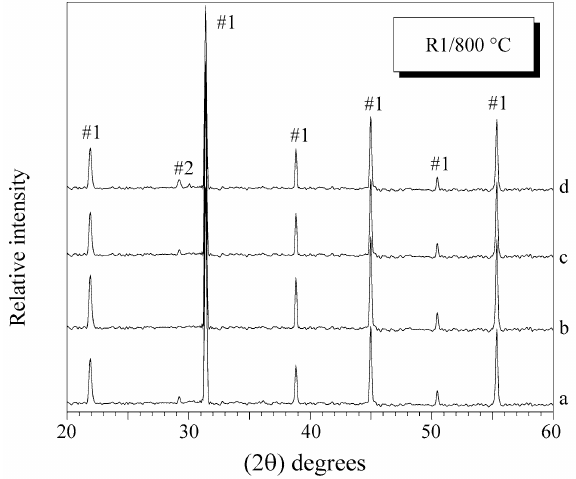
Figure 6. X-ray pattern for PMN powders prepared by route 2, calcined